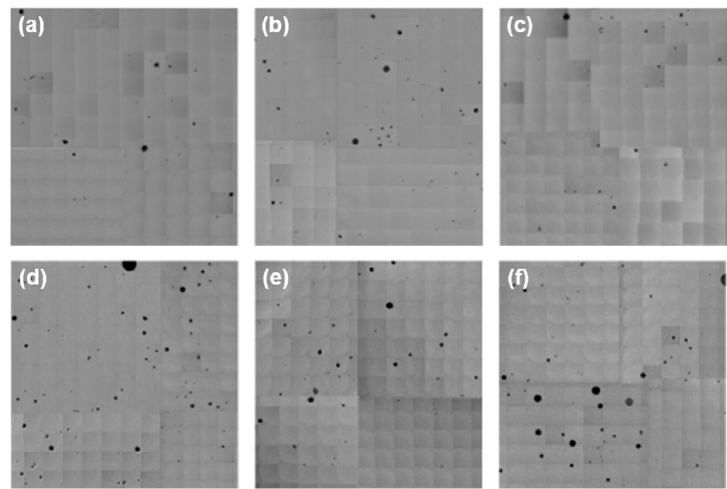
Figure 5. LSM images of bubble distribution at different depths of the tundish: ( a ) upper, ( b ) middle, and ( c ) lower portions for Trial 3 with an argon-blowing rate of 3.0 Nm 3 · h − 1 ; ( d ) upper, ( e ) middle, and ( f ) lower portions for Trial 4 with an argon-blowing rate of 5.0 Nm 3 · h − 1